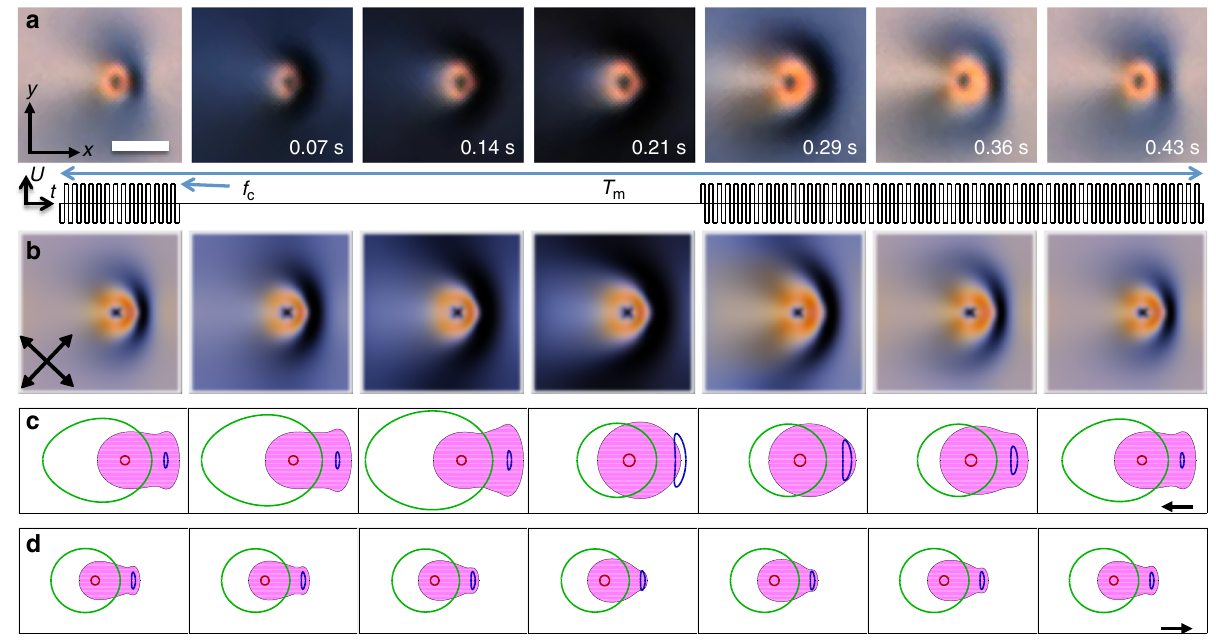
Fig. 7 POM video microscopy and modeling of squirming skyrmions. a Experimental and b computer-simulated POM micrographs of a baby skyrmion when moving along a vector connecting the south- and north-pole preimages (along positive x ), with the corresponding visualizations of squirming waves in the twisted quasi-particle illustrated in c . The scale bar in the left-side image in a is 10 µ m and applies to all POM image frames. The schematic in the inset between experimental and computer-simulated micrographs shows the timing of turning the high-frequency voltage on and off within the elapsed time t corresponding to one modulation period T m , correlated with the micrographs in a , b . Magenta fi lled surfaces in c depict the twisted regions of where the in- plane component of H / q 0 ≥ 0.1 of the chiral nematic LC. Crossed polarizers (black double arrows) in b correspond to both computer-simulated and experimental micrographs. A skyrmion is depicted for frames equally spaced in time during one cycle at f c = 1 kHz and f m = 2 Hz. After turning voltage off, the north-pole preimage expands and the south-pole preimage moves away from the north-pole preimage. Once the voltage is reinstated, the north-pole preimage localizes at a larger distance away from the south-pole preimage, and then the north- and south-pole preimages come back together within the laterally compact skyrmion that overall shifts along x , exhibiting directional motion. d Visualization of dynamics of a skyrmion quasiparticle similar to that shown in c but for f m = 20 Hz yielding an opposite direction of motion, where magenta fi lled surfaces depict the twisted regions with H / q 0 ≥ 0.05. In c , d , the red and blue contours enclose the spatial regions of the south- and north-pole preimages and the green contours show the cumulative preimage of the equatorial points of S 2 . The weaker squirming changes of these preimages and the high- H region during T m at f m = 20 Hz as compared to f m = 2 Hz are consistent with the corresponding values of the absolute velocity (Fig. 5d). Black arrows in c , d show the skyrmion ’ s motion directions at corresponding f